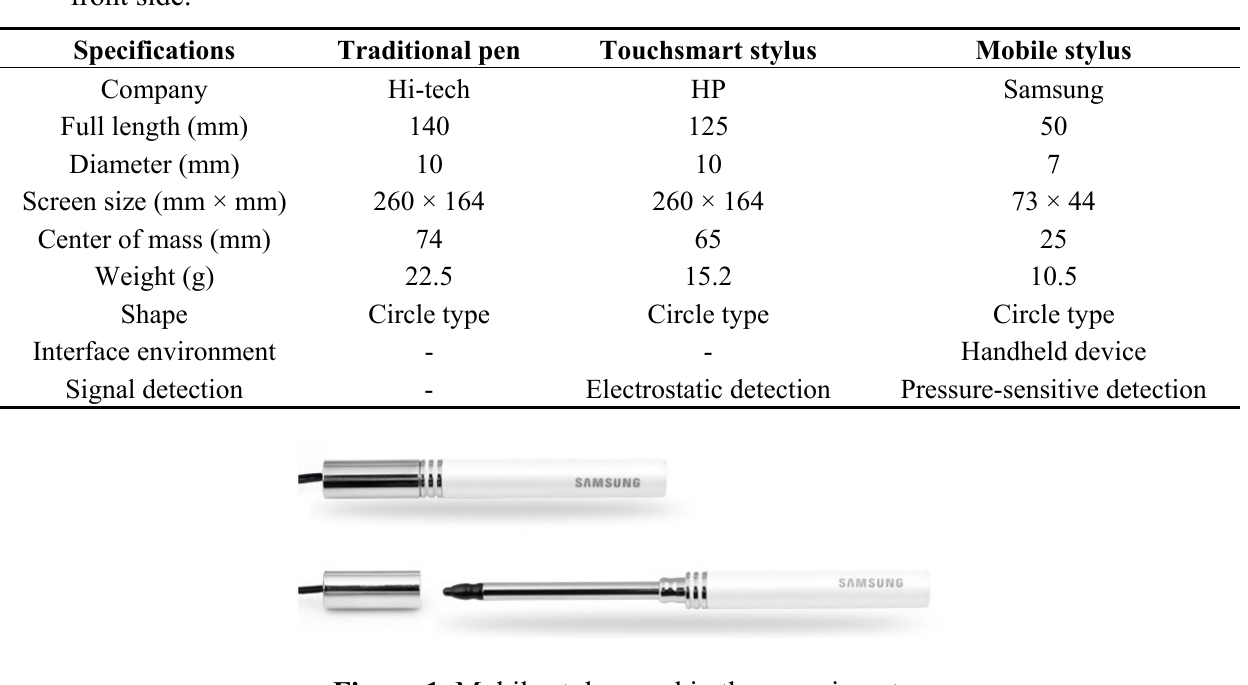
Figure 1. Mobile stylus used in the